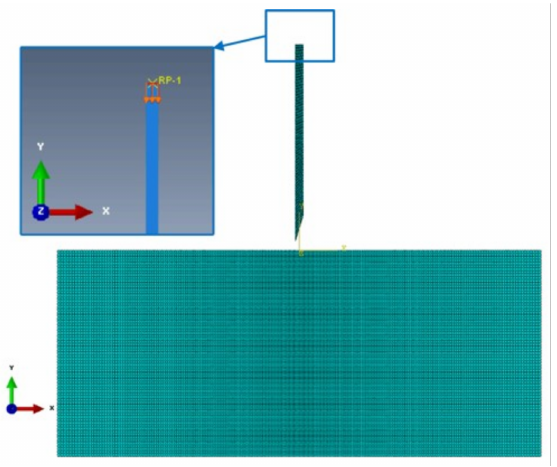
Figure 6. The model of tissue and a needle.